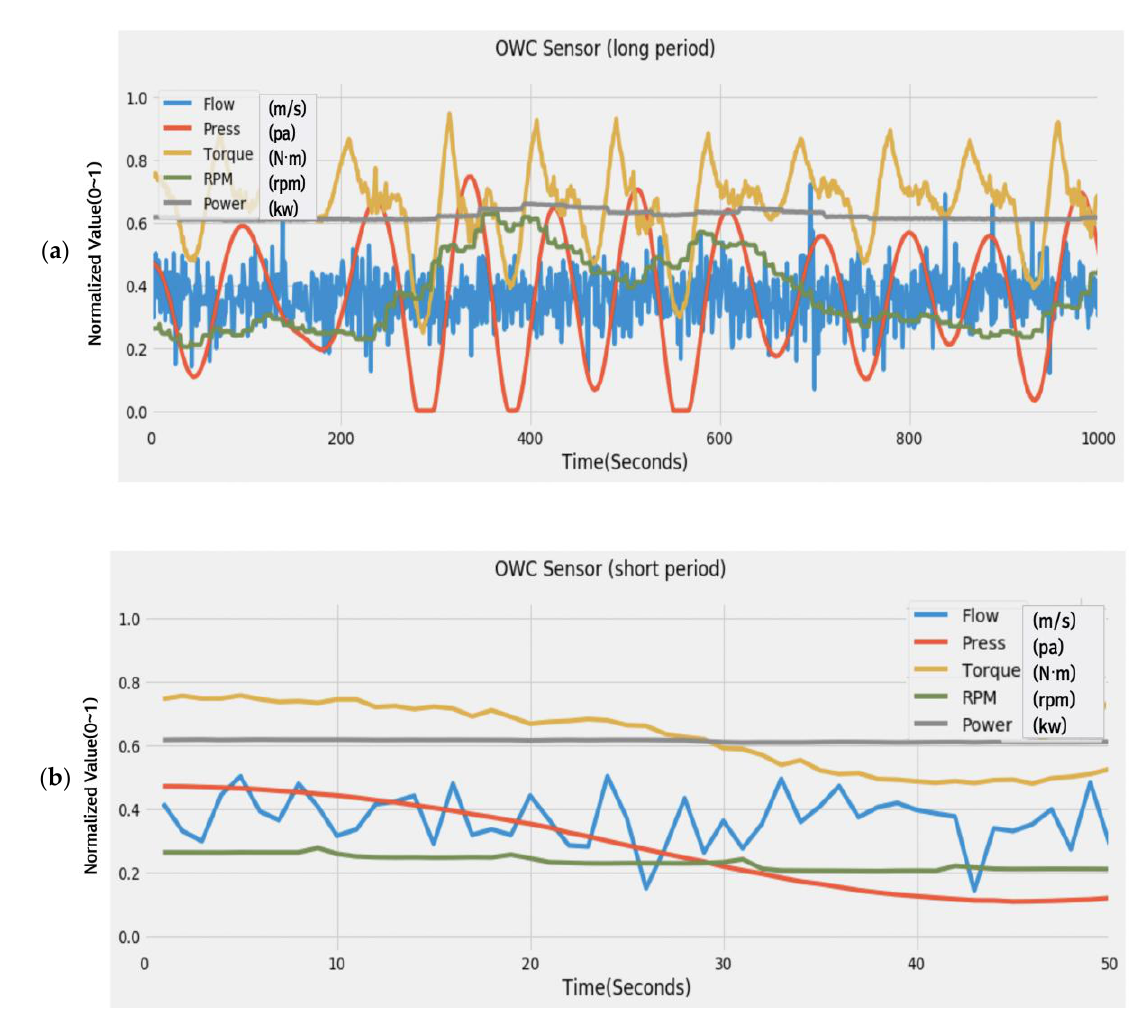
Energies 2021 , 14 , x FOR PEER REVIEW Figure 5. Raw data obtained in the OWC: ( a ) Long period; ( b ) Short period. Figure 5. Raw data obtained in the OWC: ( a ) Long period; ( b ) Short period.